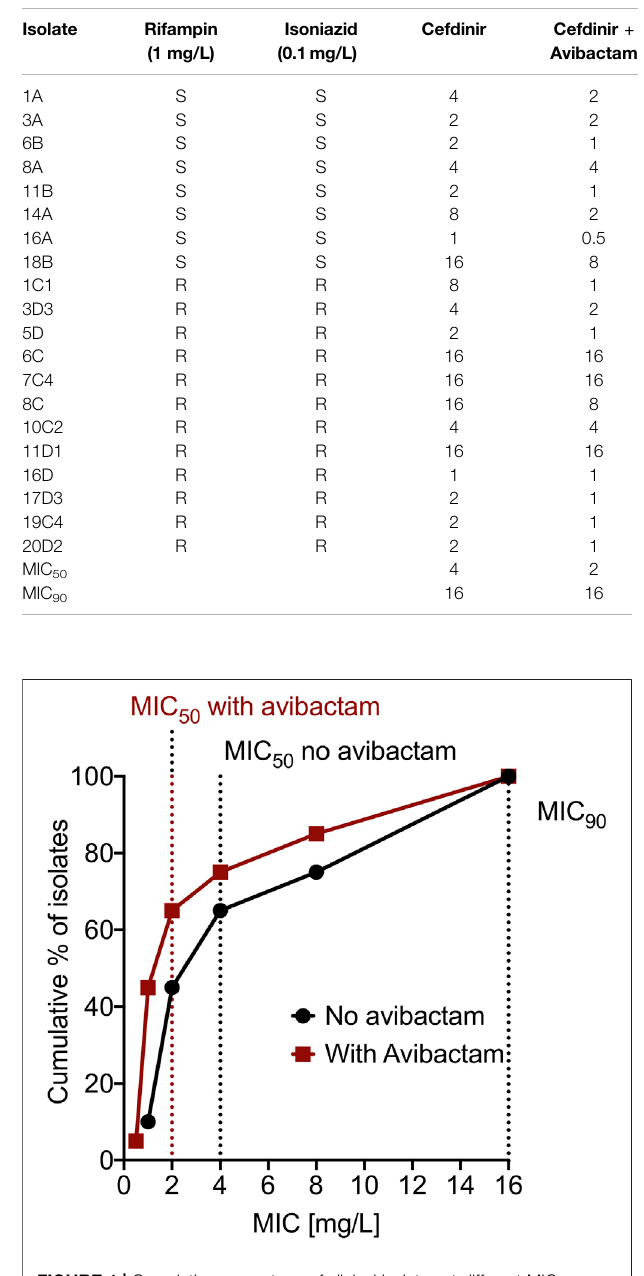
FIGURE 1 | Cumulative percentage of clinical isolates at different MIC. The dotted line on the x-axis represent MIC 50 and MIC 90 for the 20 clinical